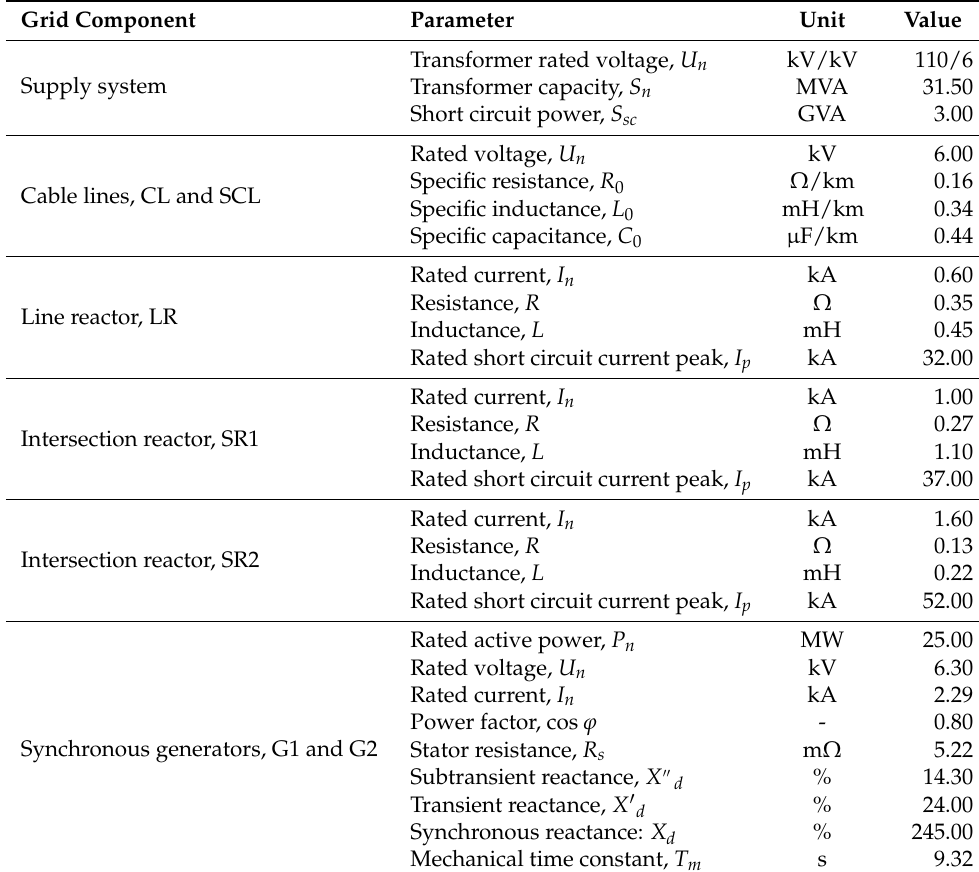
Table 1. Catalogue data of the industrial